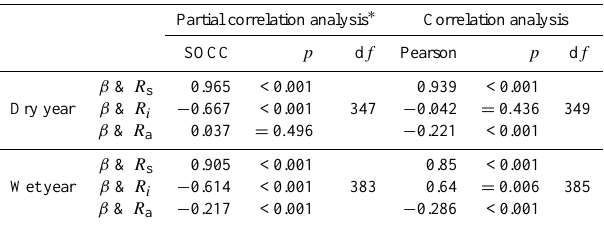
Figure 9. Seasonal variations of monthly average LAI and R s dur- ing the growing seasons in the wet years of 2007 and 2008. Table 4. The correlation analysis between the Bowen ratio ( β) and R s ,R i , and R a .